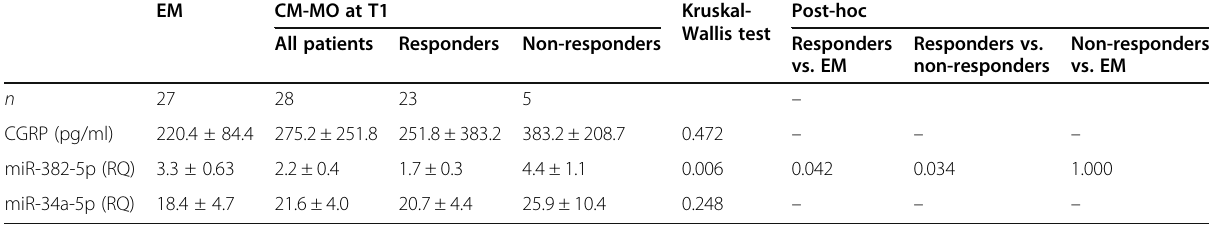
Table 4 Comparison of biochemical variables between EM and CM-MO patients after detoxification EM CM-MO at T1 Kruskal- All patients Responders Non-responders Responders